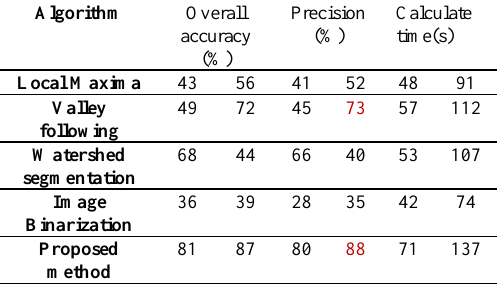
Table 1 . Assessing the accuracy of tree canopy extraction. Darab site in the left column and Neka site in the right